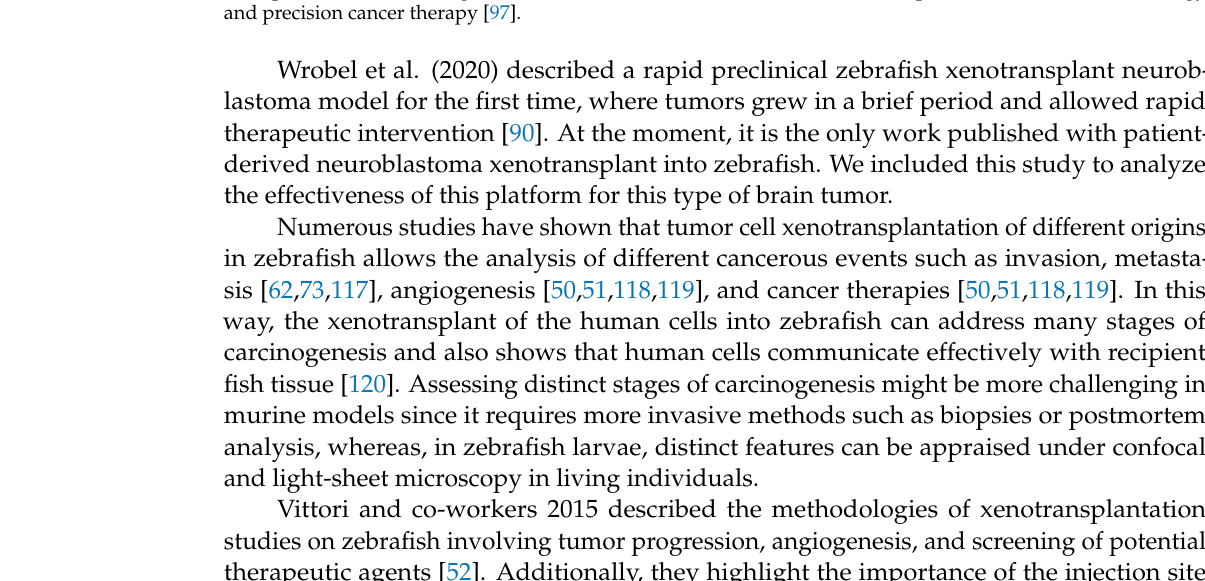
Table 2. Comparison of the main features of xenotransplants in zebrafish larvae and mice. Zebrafish PDx in Larvae Mouse PDx Assay Duration 5–7 days Weeks to months Transparency allowing assessment via microscopy Yes No Latency to tumor formation Short Long Drug screening throughput High Low Pharmacokinetic and dose optimization Number of cells per recipient PDx, patient-derived xenograft. Table created based on the review: Zebrafish patient avatars in cancer biology and precision cancer therapy